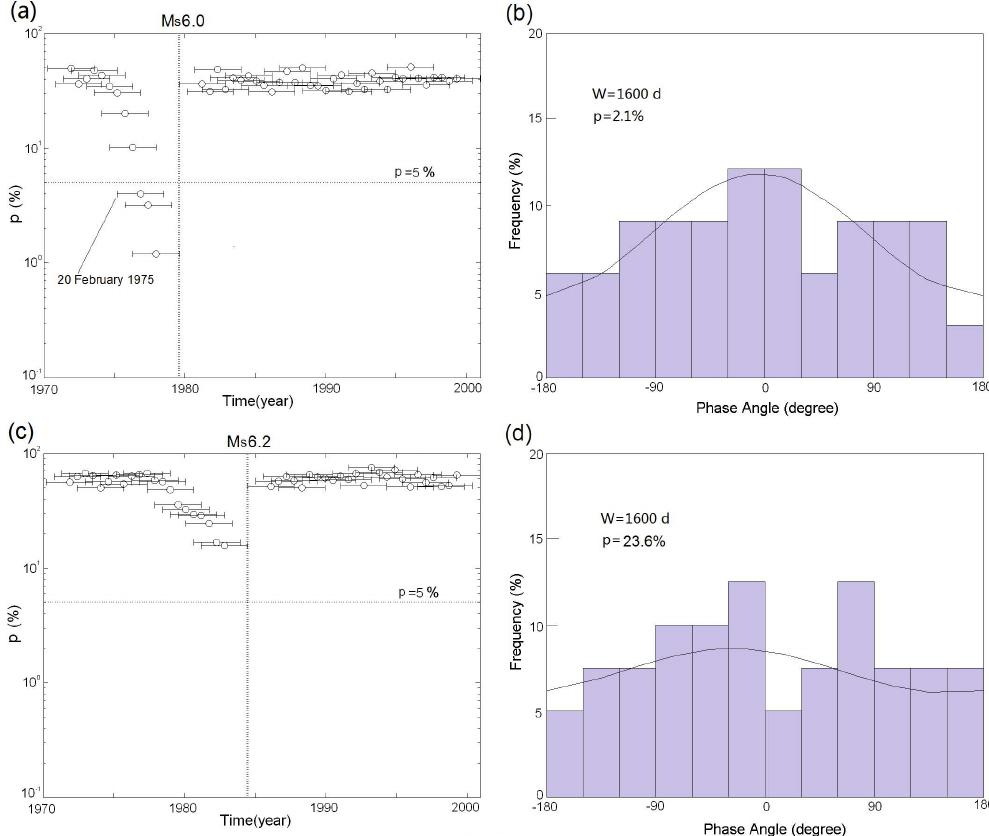
Fig. 6. (a) Variation of p value with time in the Liyang region. The time window length, indicated by a horizontal line, is 1200 days, and the step length is 200 days. (b) Phase angle frequency change for events during the period of 1600 days before the Liyang M s = 6.0 earthquake. The fine solid curve signifies a sinusoidal function which corresponds to the least square fit to the change. The fitting time window is a full period of sinusoidal function. (c) Variation of p value with time in the Wunansha region. The time window length, indicated by a horizontal line, is 1200 days, and the step length is 200 days. (d) Phase angle frequency change for events during the period of 1600 days before the Wunansha M s = 6.2 earthquake. The fine solid curve signifies a sinusoidal function which corresponds to the least square fit to the change. The fitting time window is a full period of sinusoidal